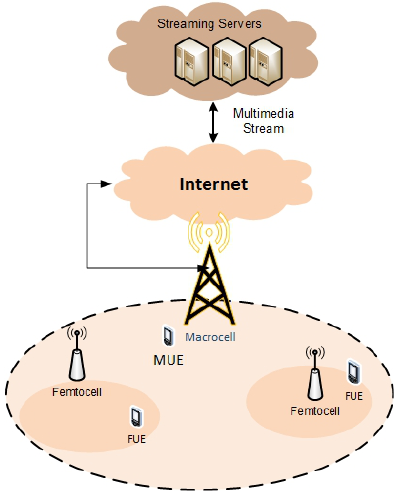
Figure 1. Video streaming system architecture with